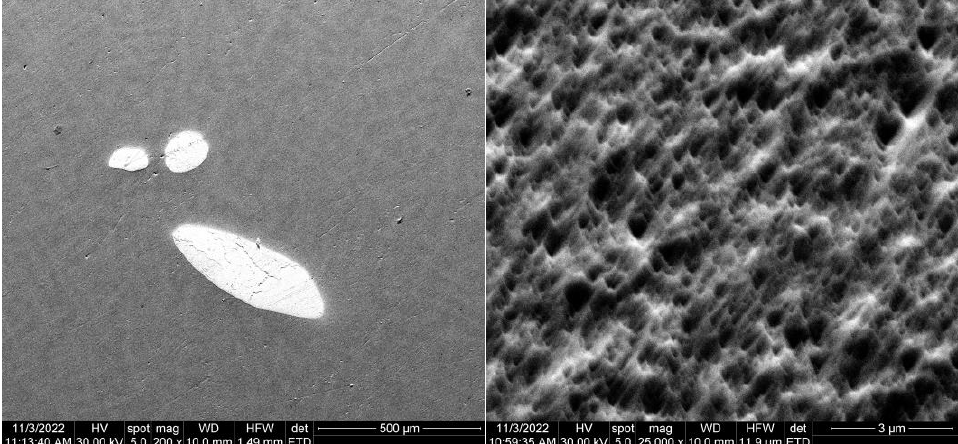
Figure 12. SEM images of a micro-zone showing tungsten accumulation ( left ) and of the corroded area ( right ) of Ti19Mo10W alloy (Code 4).